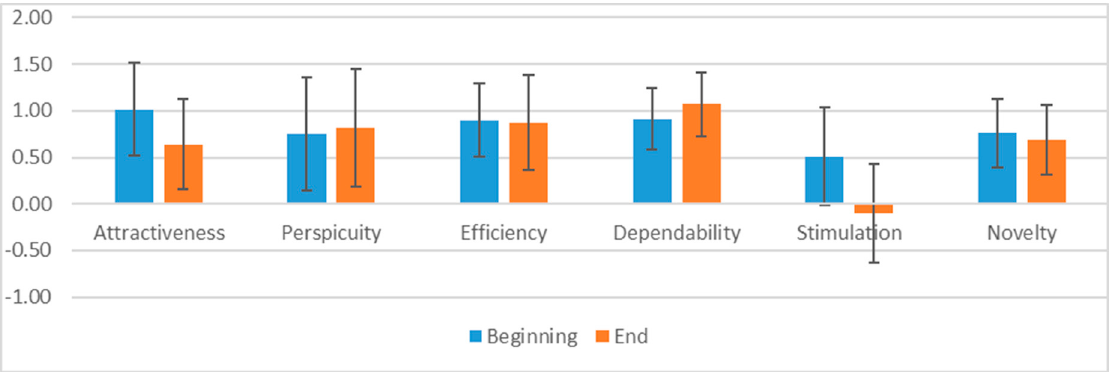
Figure 1. Comparison between User Experience Questionnaire (UEQ) at the beginning and at the end of user testing.